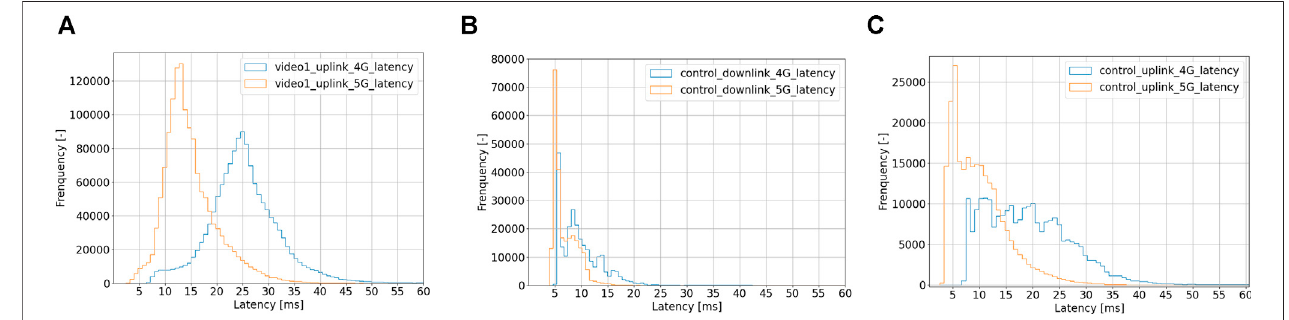
FIGURE 8 | Histogram of measured latencies [in (ms)] on 4G vs. 5G network for (A) video uplink, (B) control downlink, and (C) control